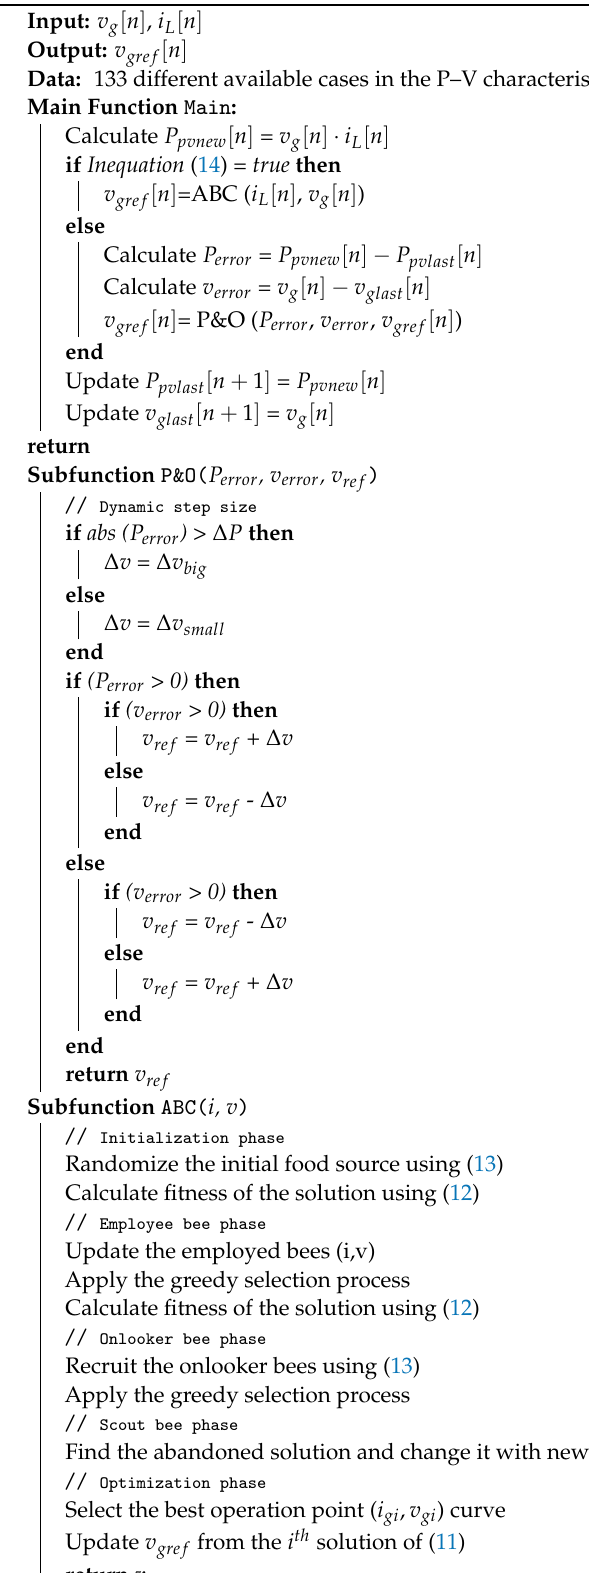
Algorithm 1: ABC-P&O MPPT algorithm running at the microcontroller (see Figure